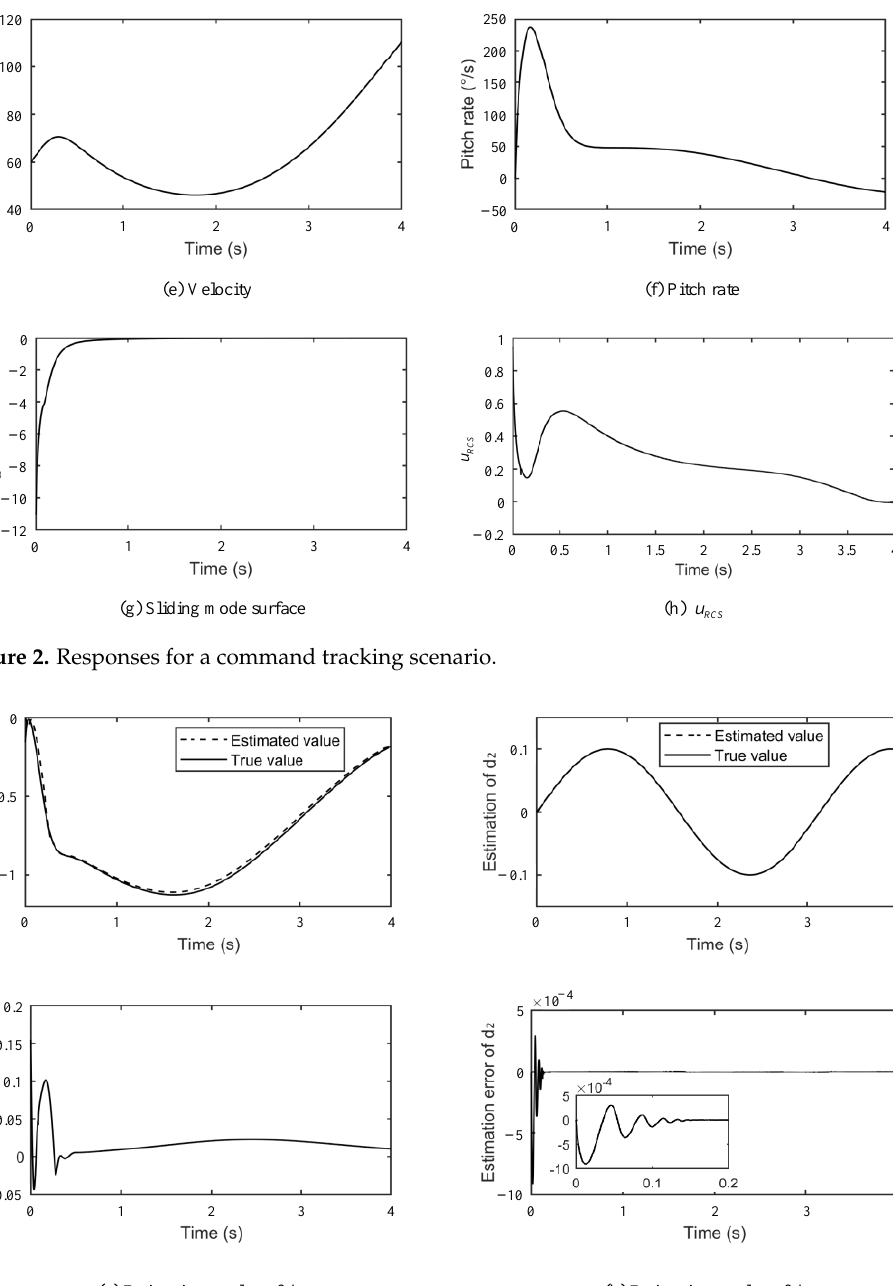
Figure 4. Dynamic scaling factor and scaling estimation error with different supervision factors. The traditional I&I method and SMC method with extended state observer (ESO) in Ref. [9] are selected for comparison to verify the effect of the proposed scheme. Responses under the traditional I&I method are illustrated in Figure 5. As seen in Figure 5a, the traditional I&I method has lower tracking accuracy compared to the proposed approach in this paper, and the overshoot of angle of attack appears. The estimation error is shown in Figure 5c, which converges more slowly in comparison with the proposed method. In addition, the convergence speed cannot be adjusted actively. Based on the sliding mode control, responses under ESO are shown in Figure 6. In the absence of the parameter estimator, the aerodynamic uncertainties are regarded as external disturbances, which can bring a great burden to the disturbance observer. As shown in Figure 6a, an obvious chattering phenomenon occurs in the angle of attack, which comes to be a poor performance compared with that seen in Figures 2a and 6c,d illustrate the estimation of mismatched and matched disturbance, respectively, from which it can see that the method in Ref. [9] has a slower estimation and lower accuracy especially when disturbances vary dramatically. So, in contrast with the traditional I&I method and SMC method with ESO, the new method has better performances on the rate of convergence and tracking precision.